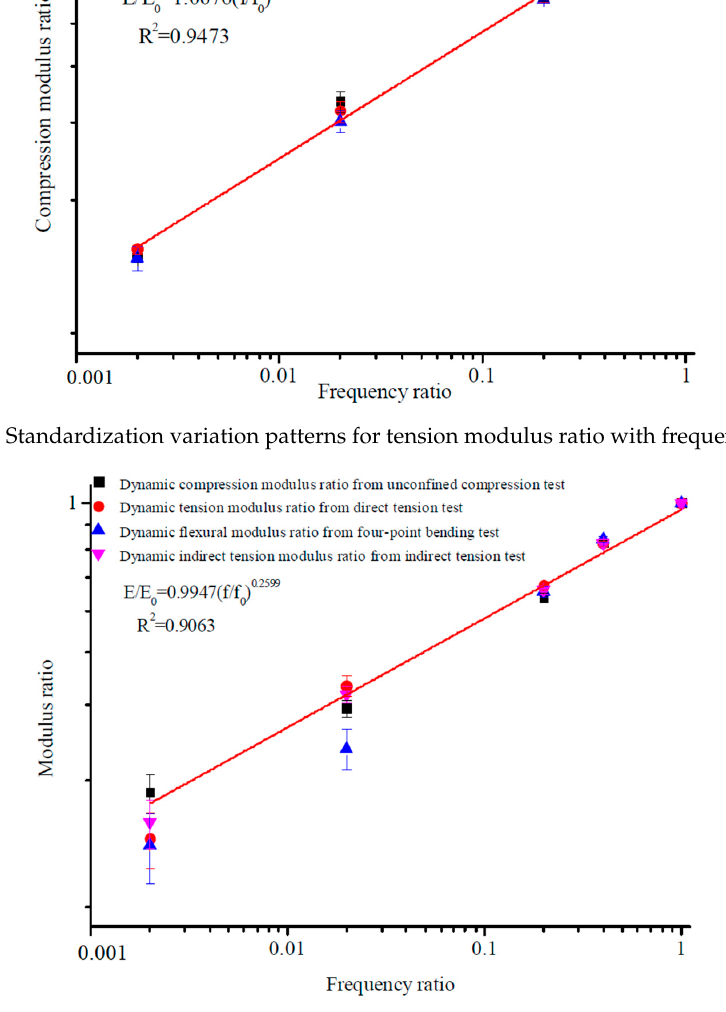
Figure 9. Standardization variation patterns for modulus ratio with frequency ratio. Table 6. Fitting results of dynamic resilient moduli ratio by standardization under different loading frequencies ratio.